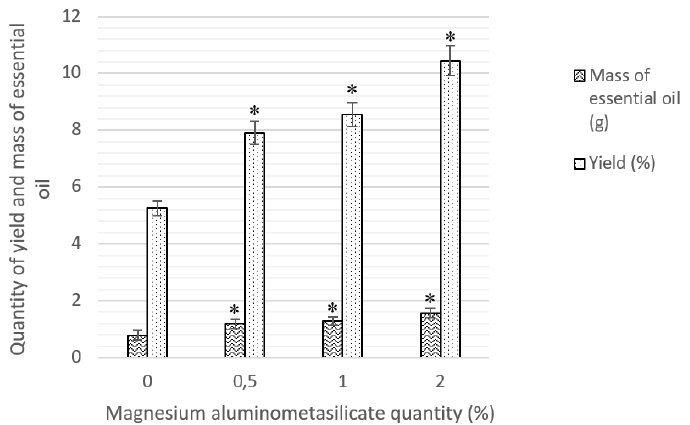
Figure 2. Essential oils’ mass and yield from nutmeg using HD and HD with magnesium aluminometasilicate. Mass and yield of essential oil, * p < 0.05 versus hydrodistillation without magnesium aluminometasilicate.